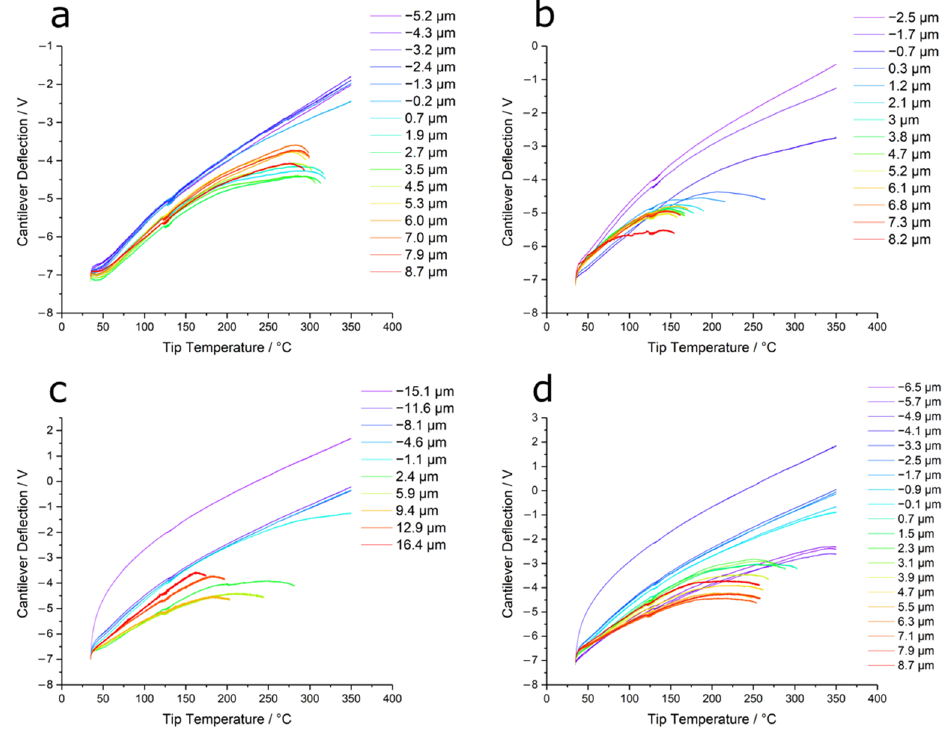
Figure A7. NanoTA temperature profiles of PPB traversing the domain boundary, with ( a – d ) corre- sponding to the domain boundaries shown in Figure A8(ai–aiv), respectively.